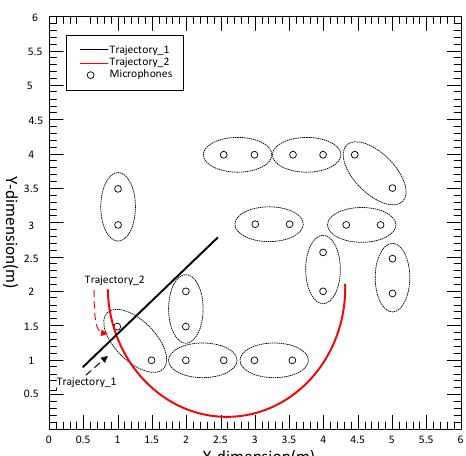
Figure 3. Microphone deployments and acoustic source trajectories: the black line denotes trajectory 1, the black dashed arrow denotes the motion direction of trajectory 1, the red semicircle denotes trajectory 2, the red dashed arrow denotes the motion direction of trajectory 2.